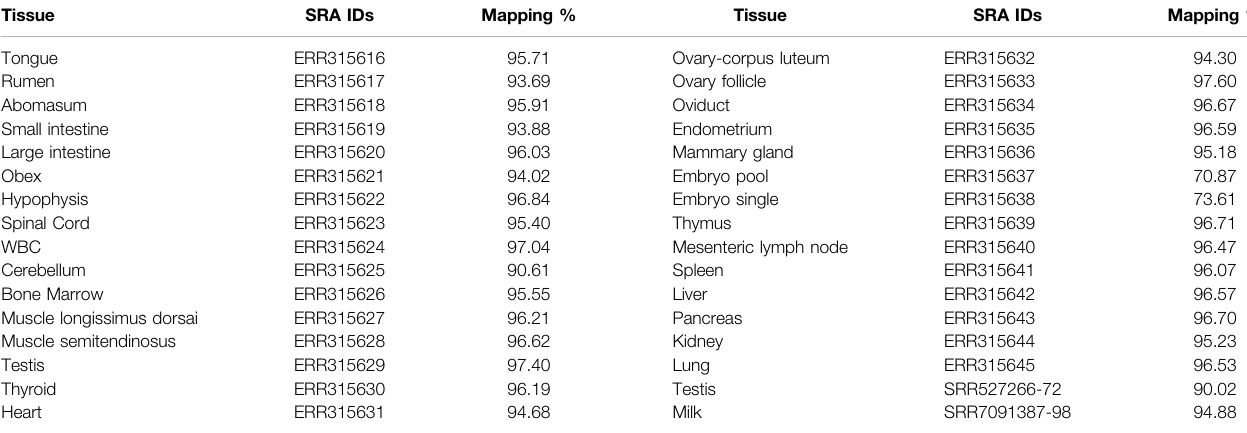
TABLE 2 | The details of RNA-seq data from the International Water Buffalo Genome Project representing different buffalo tissues along with SRA IDs and mapping %.